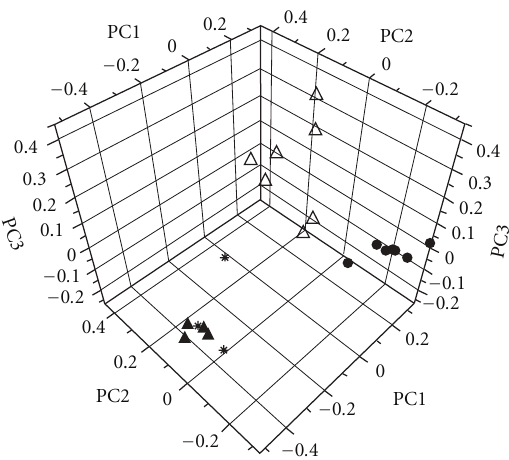
Figure 3: Combined analysis of the metabolomic dataset based on the 1 H NMR spectra of urine samples from Zucker obese rats ( (cid:2) ), Zucker lean rats ( ∗ ), GK rats ( • ), and Wistar rats ( (cid:3) ), respectively.